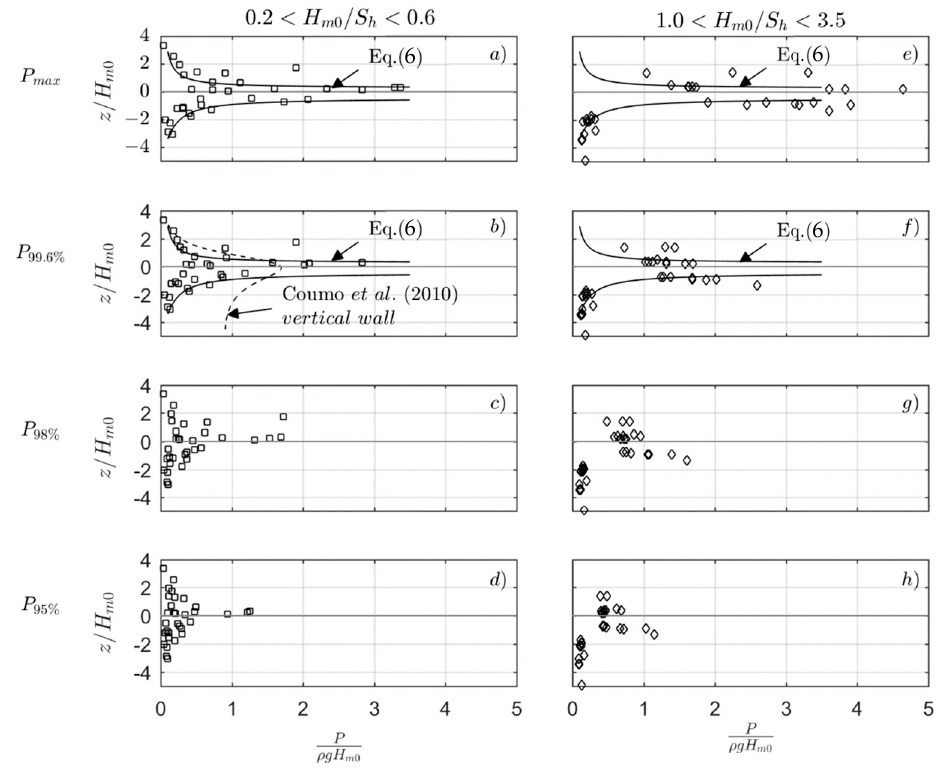
Figure 10. Normalized horizontal pressure impacts with varying probability of exceedance and corresponding relative water depth z / H m 0 for large (0.2 < H m 0 / S h < 0.6) and small (1.0 < H m 0 / S h < 3.5) stepped revetments including theoretical laws for stepped revetments according to Equation (6) and for vertical walls according to Reference [11].